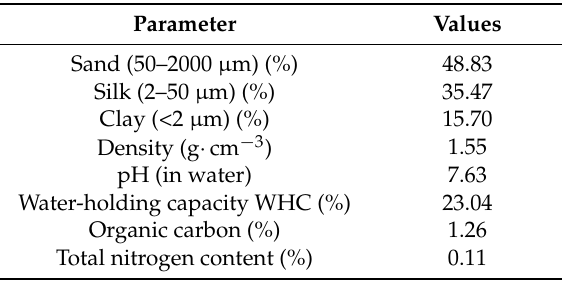
Table 1. Physical and chemical properties of soil used in this